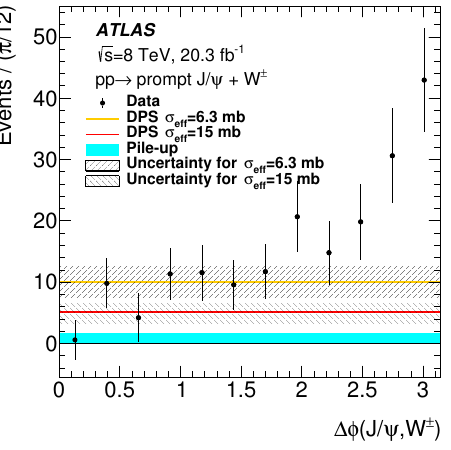
Figure 2. The sPlot-weighted opening angle (cid:1) (cid:30) ( J= ; W (cid:6) ) for prompt J= + W (cid:6) candidates, uncorrected for e(cid:14)ciency or acceptance, compared with the sum of the expected pileup and DPS contributions. The data are not corrected for J= + V backgrounds which contribute (cid:24) 10% and have a shape similar to the overall distribution. The DPS contribution is shown for two (cid:27) e(cid:11) values, 15 mb and 6 : 3 mb, as described in the text. The peak at (cid:1) (cid:30) ’ (cid:25) is assumed to come primarily from SPS